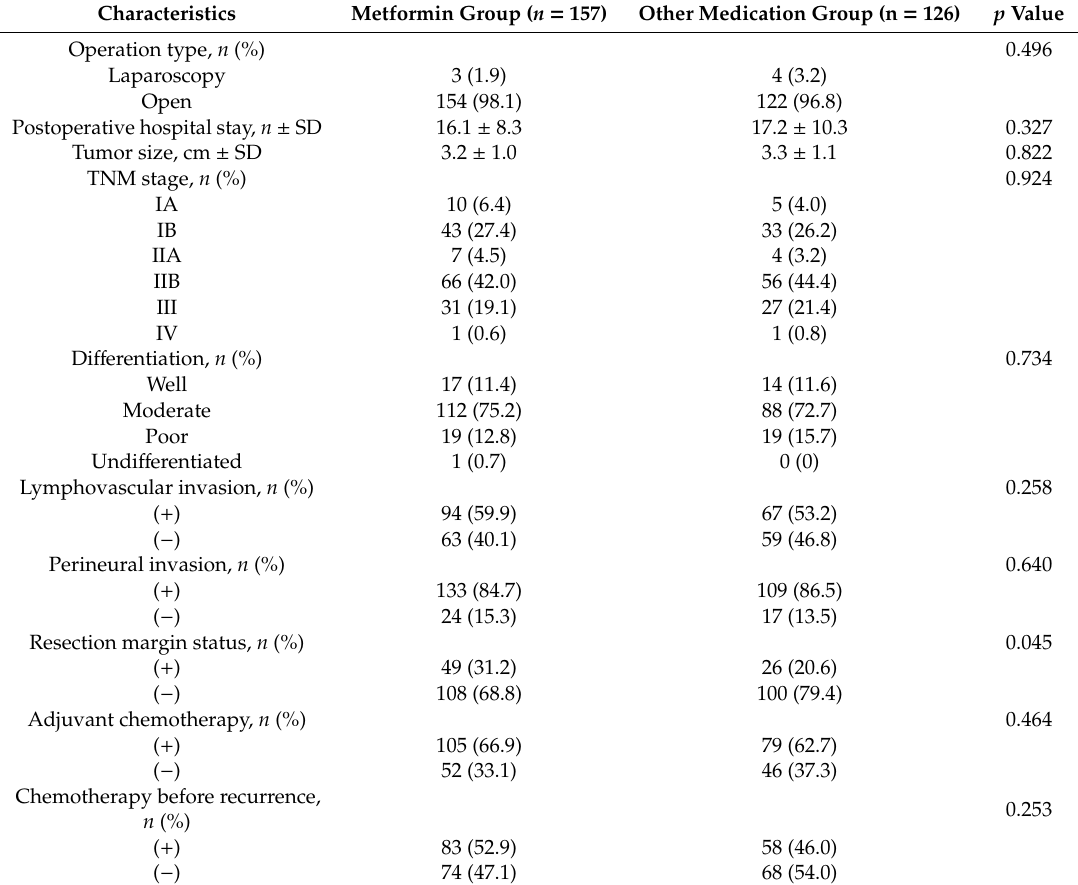
Table 2. Postoperative data of the metformin group and the other medication